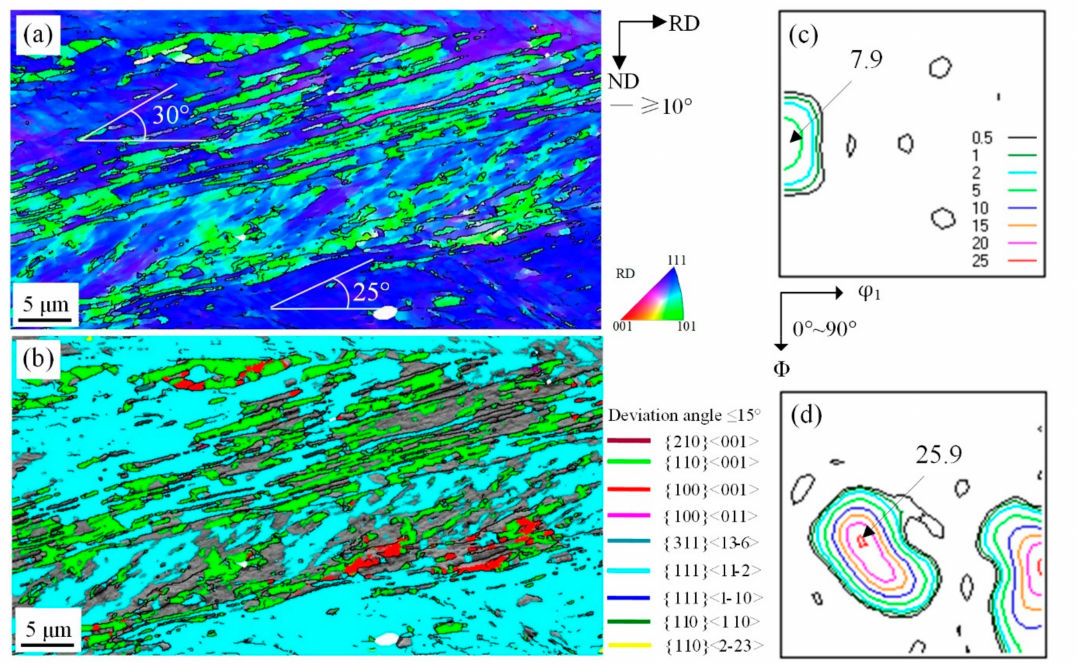
Figure 8. EBSD orientation maps of shear bands with {111}<112> under 77 reduction ( a ) ESBD inverse pole figure of cold-rolled sheet; ( b ) several texture components colored in orientation maps of cold-rolled sheet (deviation angle ≤ 15 ◦ ); ( c ) ODF of EBSD data presented at ϕ 2 = 0 ◦ section; ( d ) ODF of EBSD data presented at ϕ 2 = 45 ◦